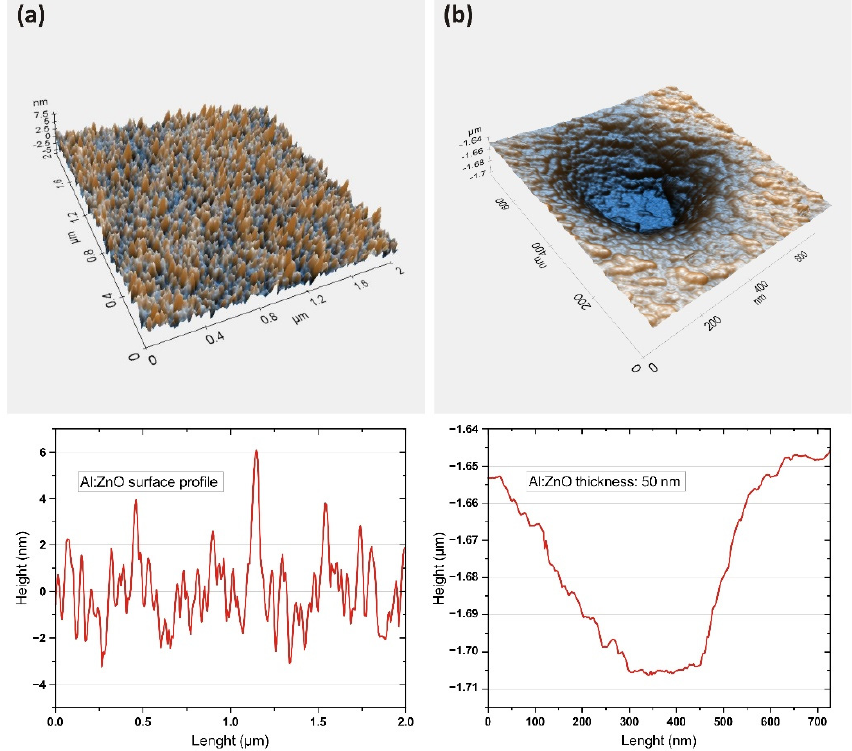
Figure 3. ( a ) Anisotropic AFM image of the room-temperature magnetron-sputtered Al:ZnO layer surface profile; ( b ) thickness measurements.